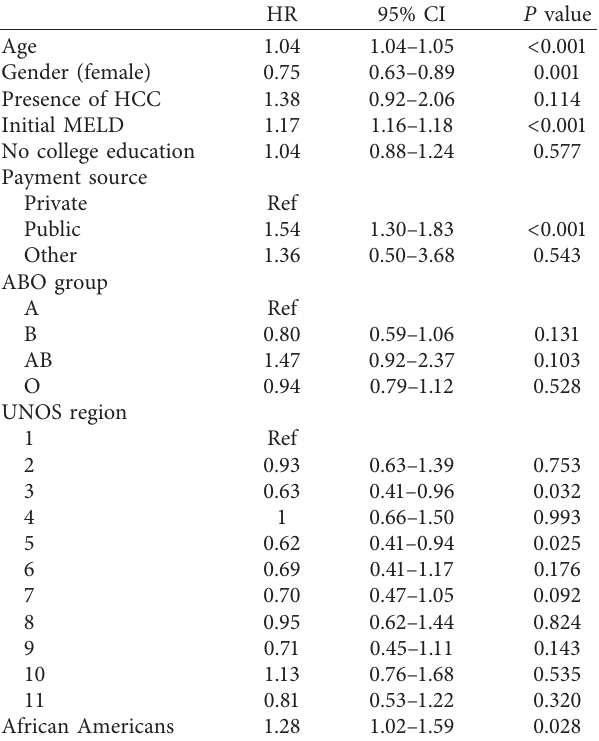
Table 2: Multivariate Cox proportional hazards model for waitlist survival.